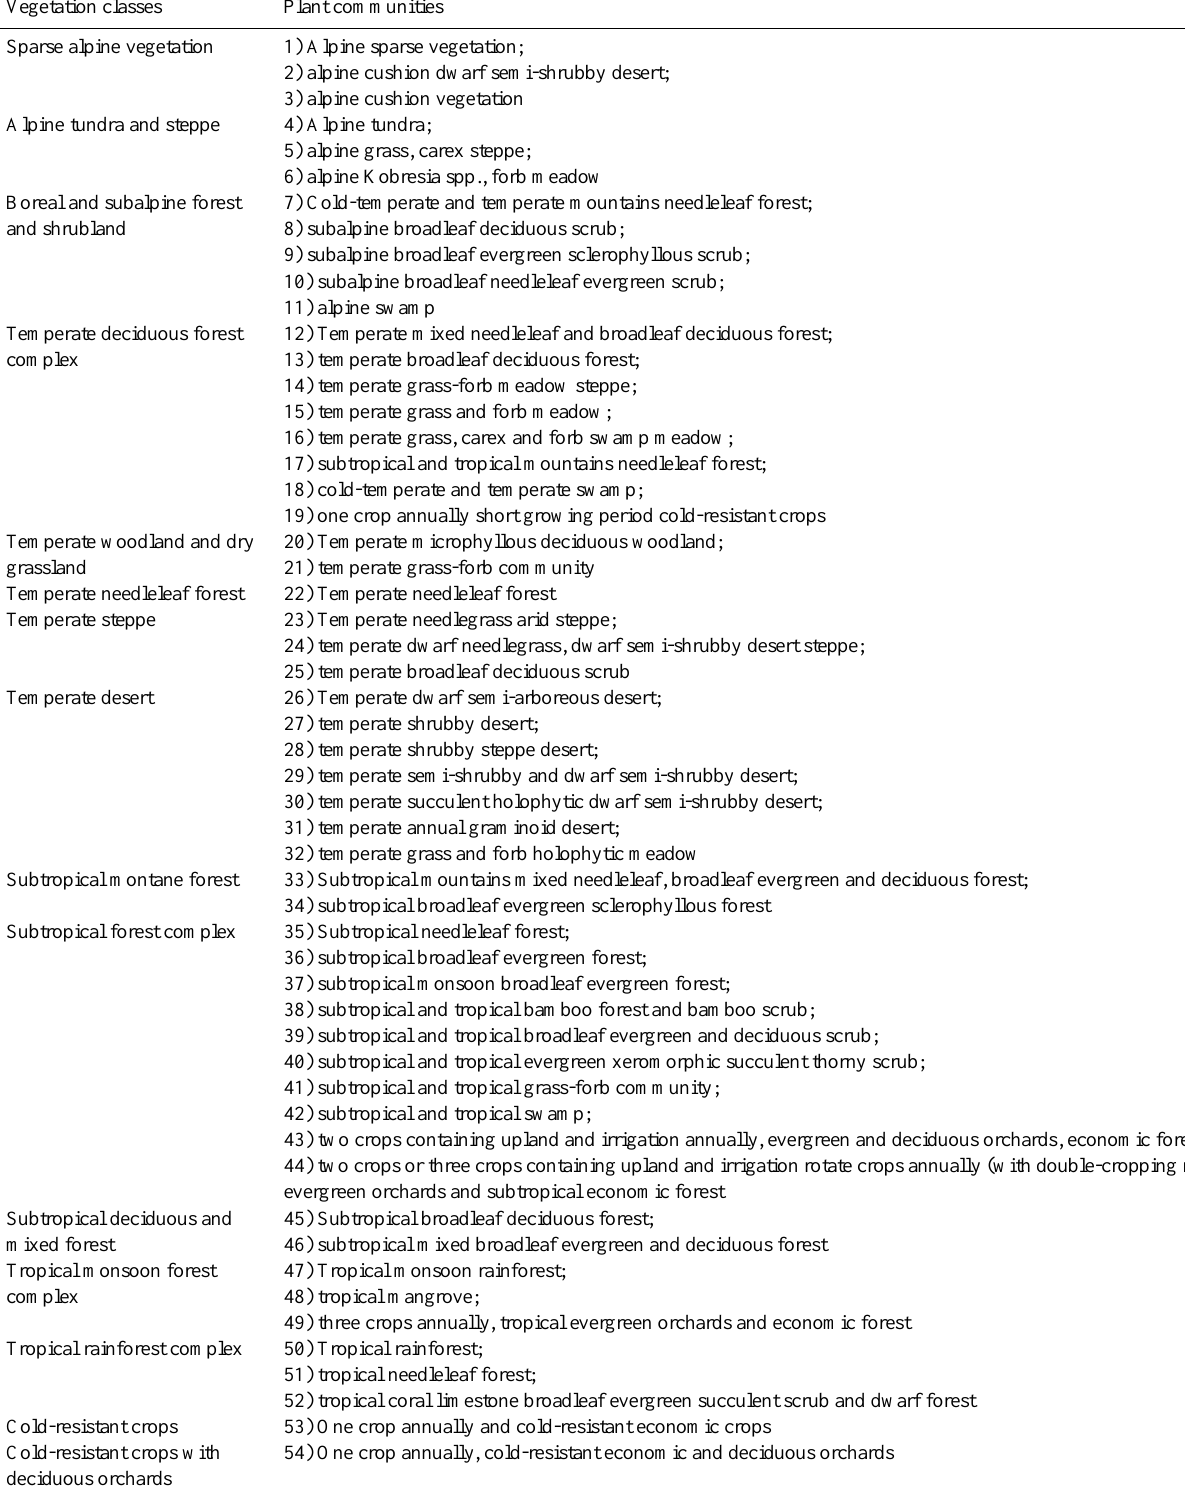
Table 1. Allocation of observed plant communities from the Vegetation Atlas of China at a scale of 1 : 1 million (Hou, 2001) to vegetation classes, based on k -means clustering with modifications as described in the